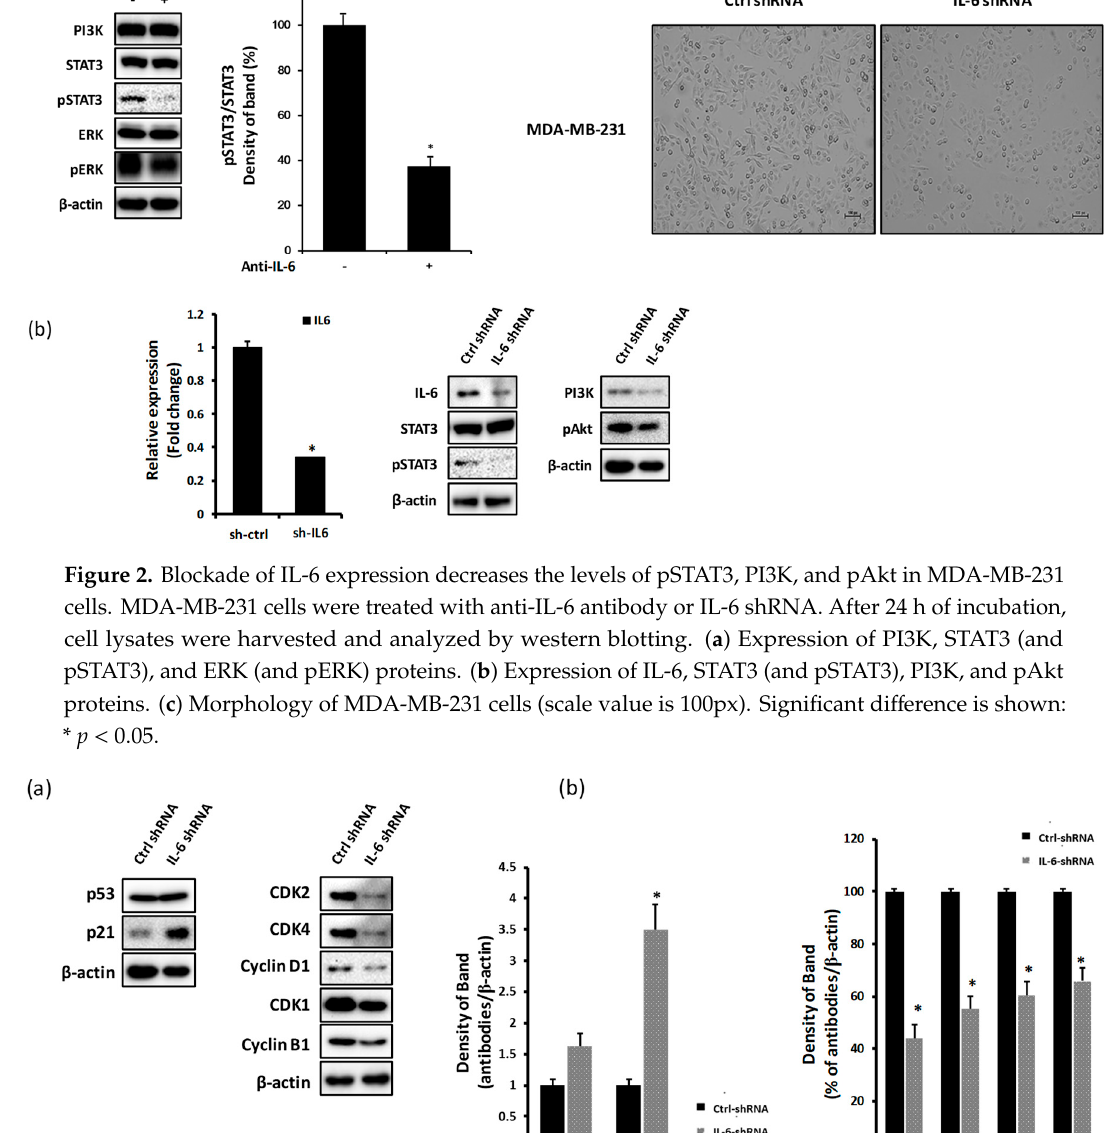
Figure 3. Blockage of IL-6 expression decreases cyclin-dependent kinases (CDK) and cyclin protein expression and induces p21 expression in MDA-MB-231 cells. MDA-MB-231 cells were seeded in six-well plates at a density of 5 × 10 5 cells / well and treated with IL-6 shRNA or control shRNA. Cell lysates were harvested and analyzed by western blotting. ( a ) Expression of p53 and p21 proteins. ( b ) Expression of CDKs (CDK2, CDK4, and CDK1) and cyclins (cyclin D1 and cyclin B1). Significant di ff erence is shown: * p <